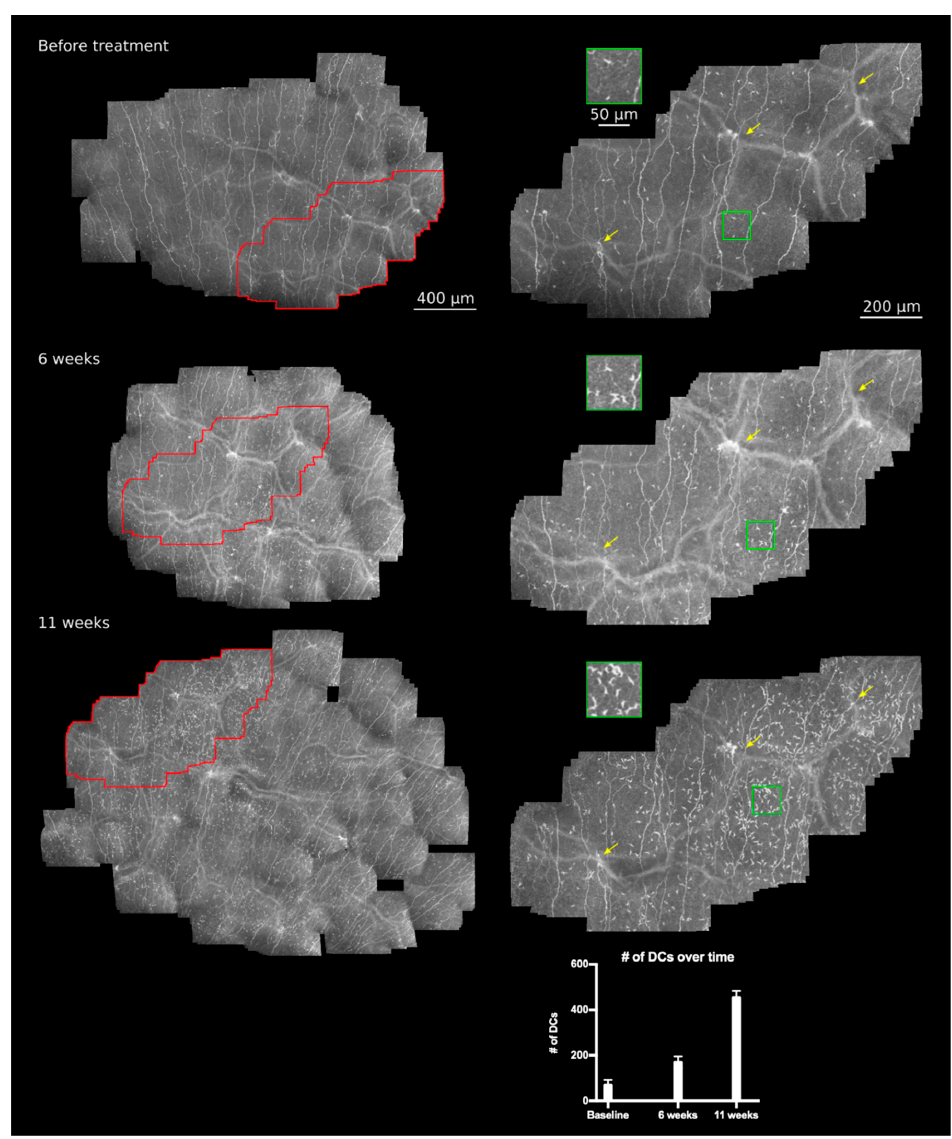
Figure 2. Longitudinal in vivo large-area CLSM scans of the SNP of a HER-2 positive breast cancer patient during paclitaxel and trastuzumab therapy. From top to bottom: The patient’s SNP before treatment, at 6 weeks, and at 11 weeks of treatment. Identical areas within all reconstructed images (left side: red areas, right side: enlarged view of red marked areas) could be assigned by characteristic recurring patterns (yellow arrows). During the therapy regimen, the DC density increased and showed a regional burst at 11 weeks after the start of therapy. The bar plot shows the manual count of DC density over time within identical areas. Nerve fiber density and morphology remained stable except for minor fluctuations. Red area: identical area; green area and inset: DC density.